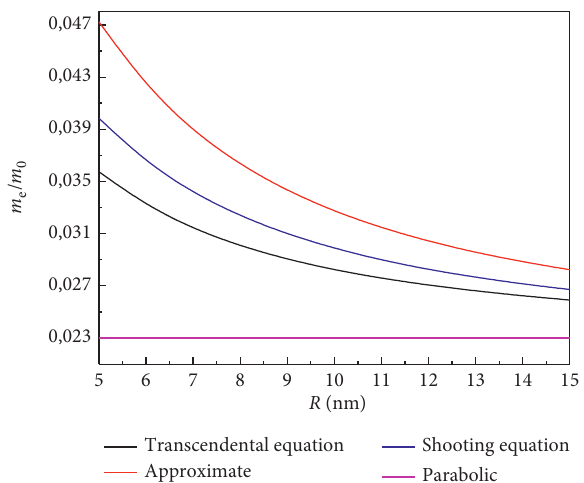
Figure 8: The dependence of the effective electron mass on the radius of a cylindrical quantum wire with a finite potential.